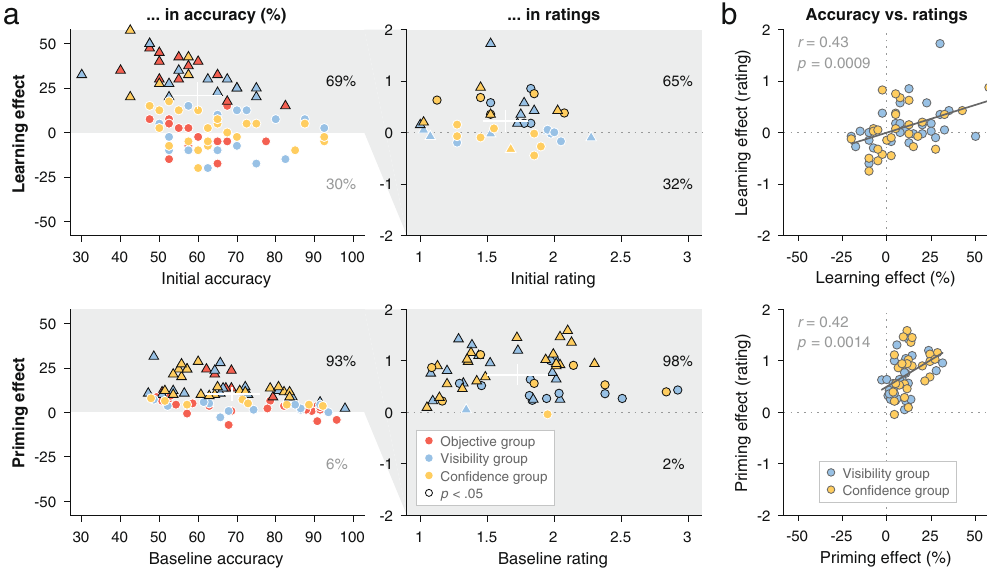
Figure 3. Distinct contributions of learning and priming to rapid perceptual enhancement in hard trials. ( a ) The learning effect in accuracy (top panels, y axis)—the difference in identification accuracy between the single block at peak performance and the first single block (i.e., initial accuracy, x axis)—was positive in 69% of participants (left), and only a subset of them showed corresponding improvements in visibility or confidence ratings (right). On the other hand, the priming effect in accuracy (bottom panels, y axis)—the difference in hard-trial accuracy between the mix segment and the pre-mix segment (i.e., baseline, x axis)—was positive in 93% of participants (left), and most of them showed corresponding improvements in visibility or confidence ratings (right). Percentages represent the proportions of participants showing positive or negative effects; there were three mixture groups for accuracy and two rating groups for ratings. Each dot or triangle represents an individual participant (triangle denotes statistically significant accuracy effect at the individual level, p < 0.05); black contour denotes statistically significant effect at the individual level, p < 0.05, one-tailed (white contour, non-significant effect); center of the white bar, mean of all the individuals within the highlighted (gray) region; full length of the white bar, a standard deviation. ( b ) Accuracy effects and rating effects were strongly correlated with each other, with comparable magnitudes in learning and in priming. The solid line represents linear regression fitting; it was shallower in learning (top) than in priming (bottom), but the difference was not statistically significant ( F (1, 108) = 2.03, p =